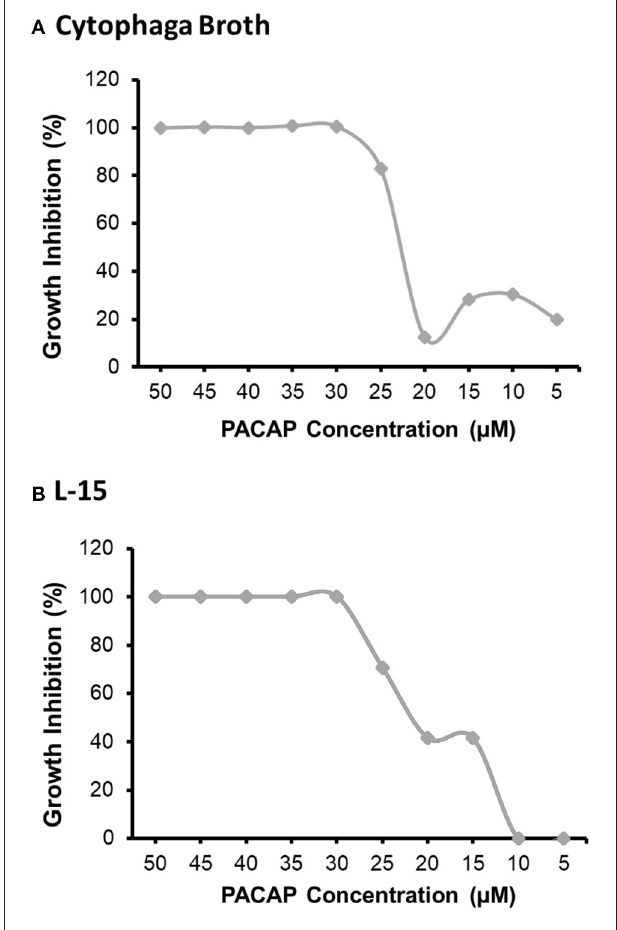
FIGURE 1 | The minimum inhibitory concentration (MIC) of C. gariepinus PACAP-38 required to prevent the growth of F. psychrophilum alone. The MIC was determined following 3 days of growth in both cytophaga broth (A) and in Leibovitz-15 (L-15) cell culture media (B) . Each panel represents the results of three independent